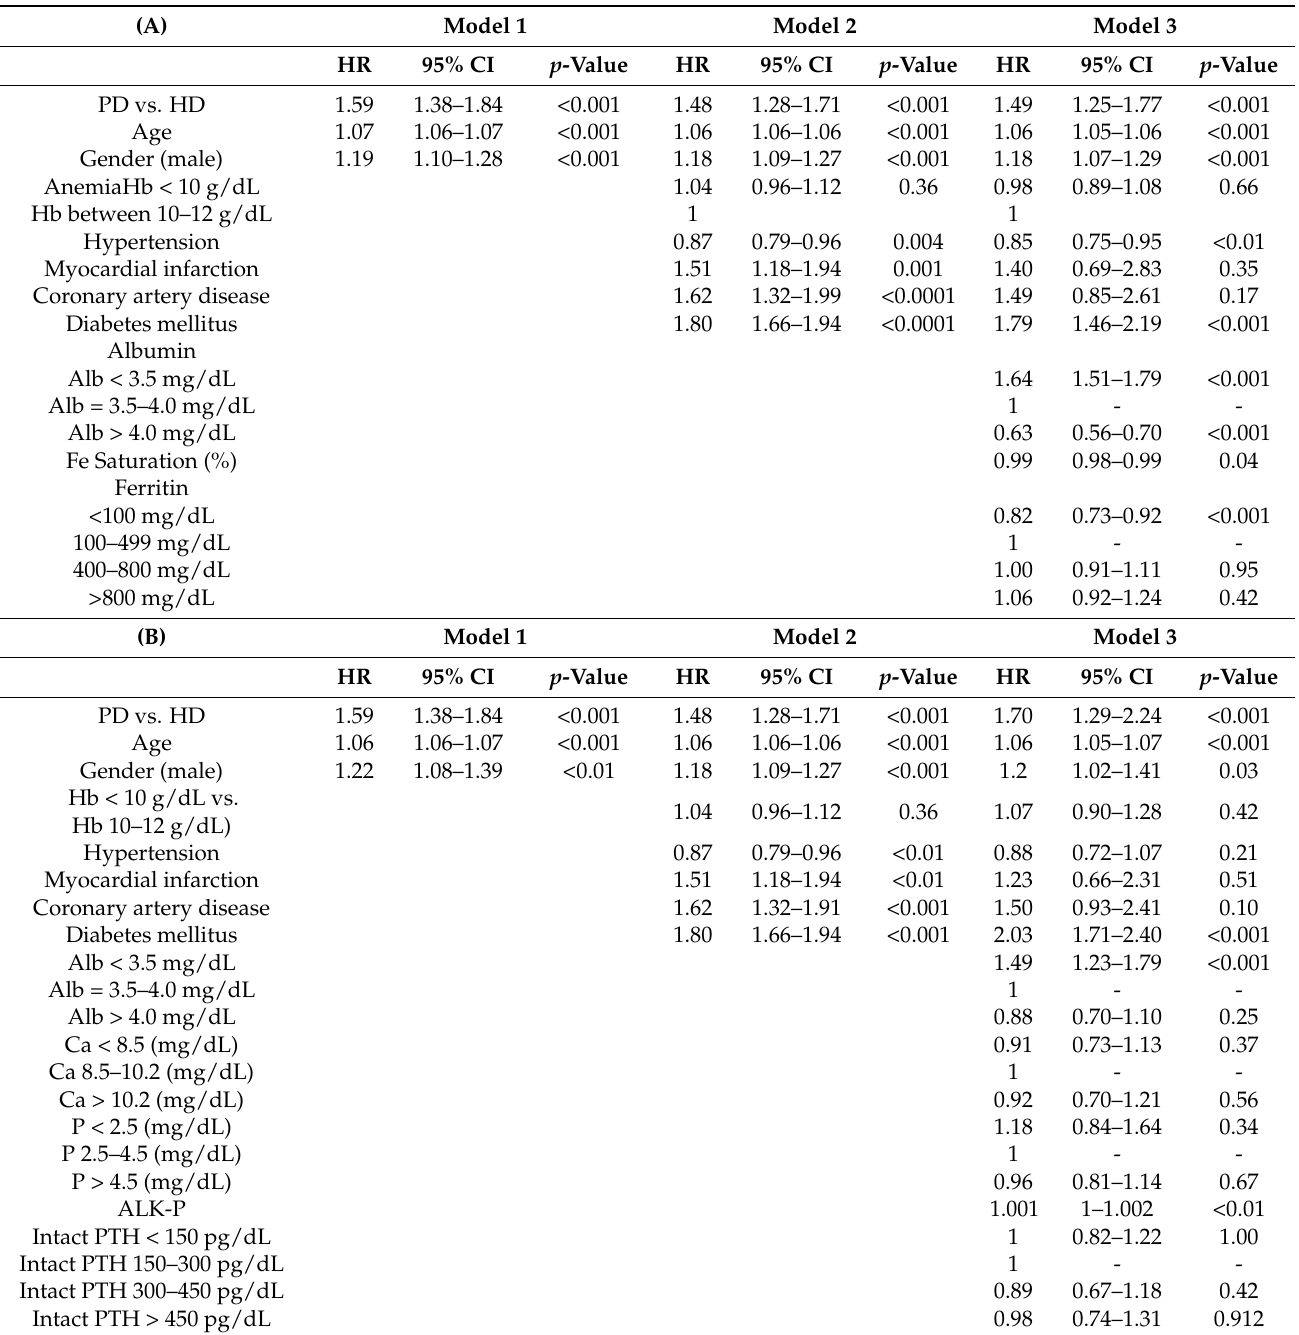
Table 3. ( A ) Hazard ratio (HR) of 5-year all-cause mortality in the whole population (N =